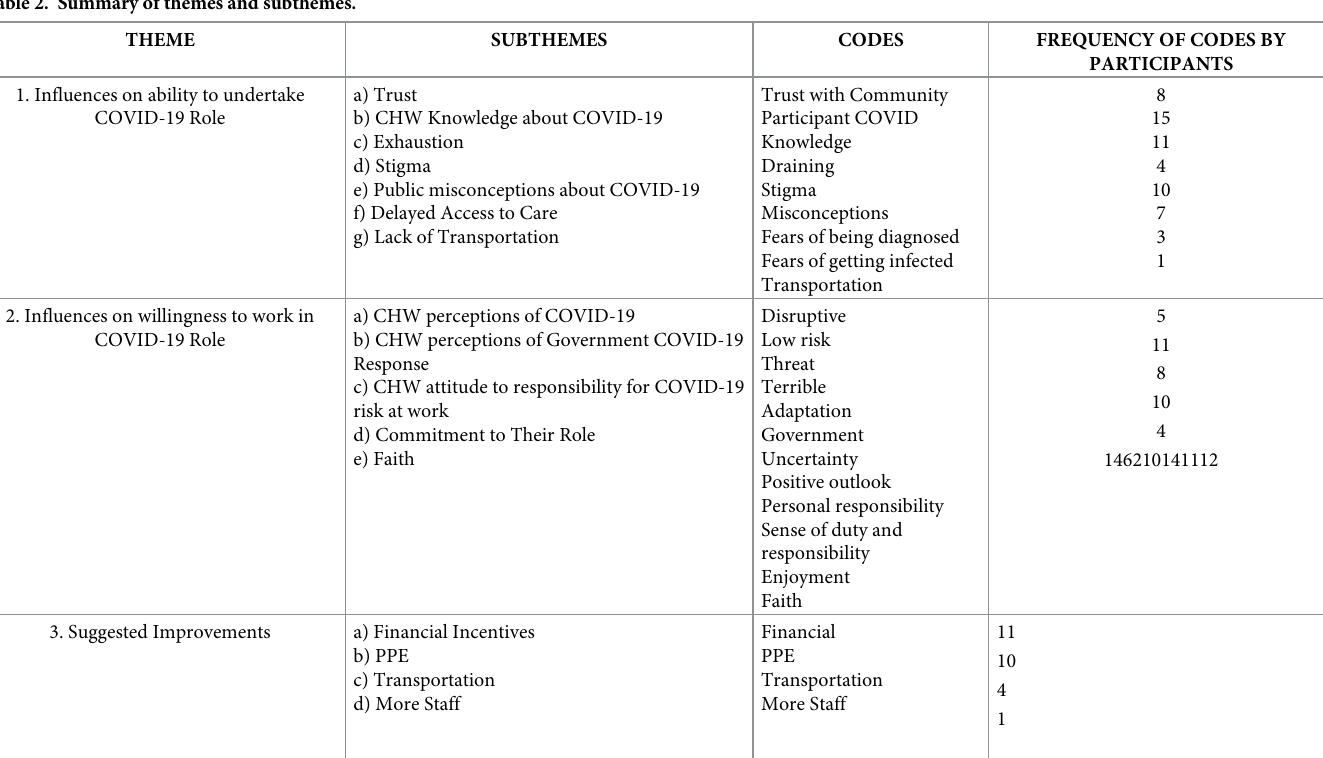
Table 2. Summary of themes and